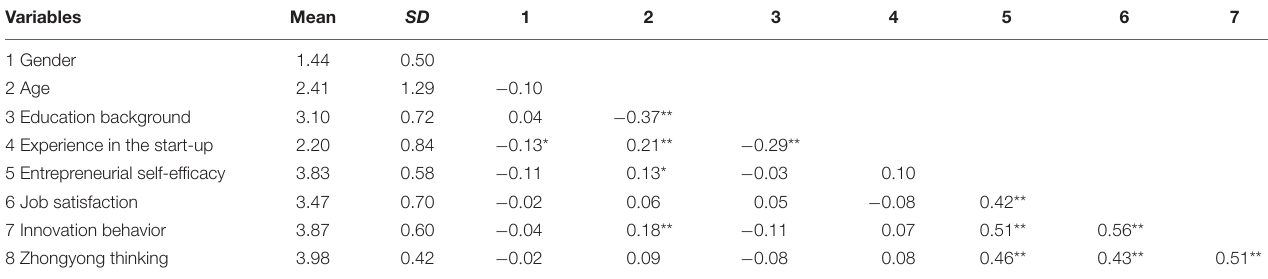
TABLE 3 | Descriptive statistics and correlations among the variables.